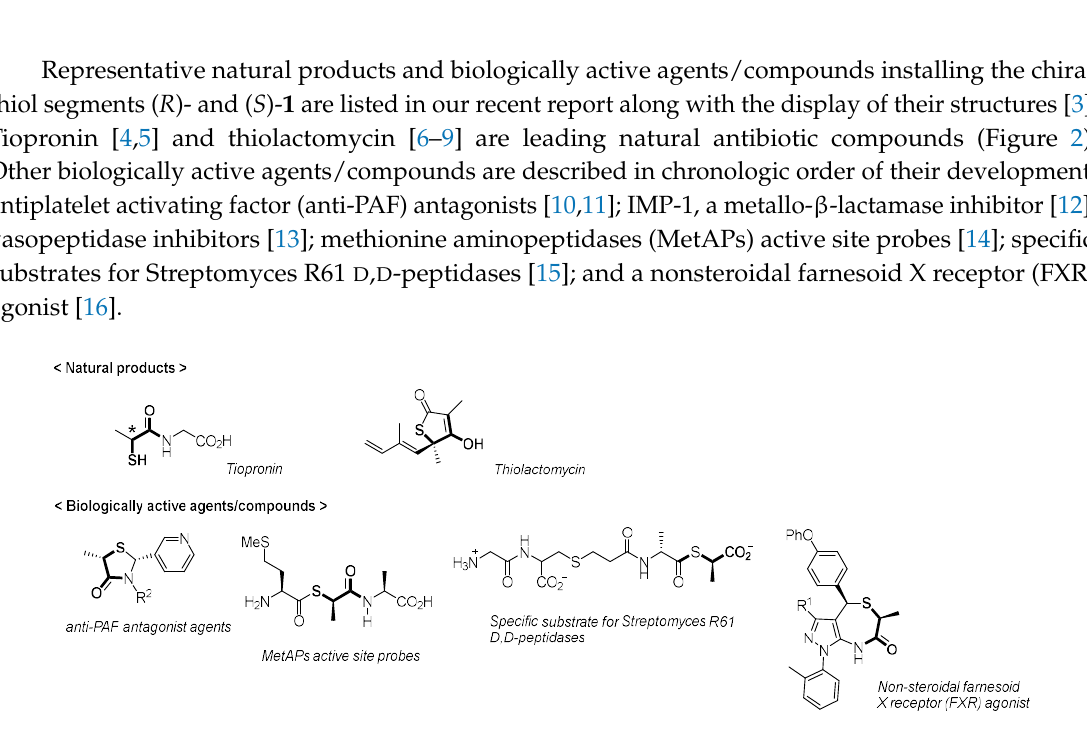
Figure 2. Representative natural products containing chiral thiol segments ( R )- or ( S )- 1 .